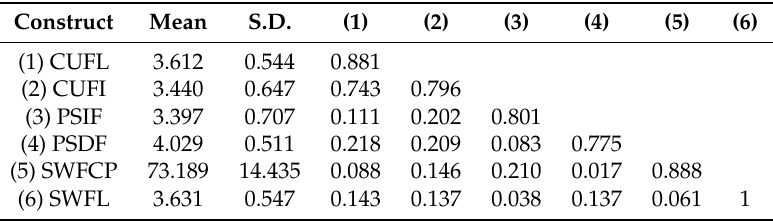
Table 4. Discriminant